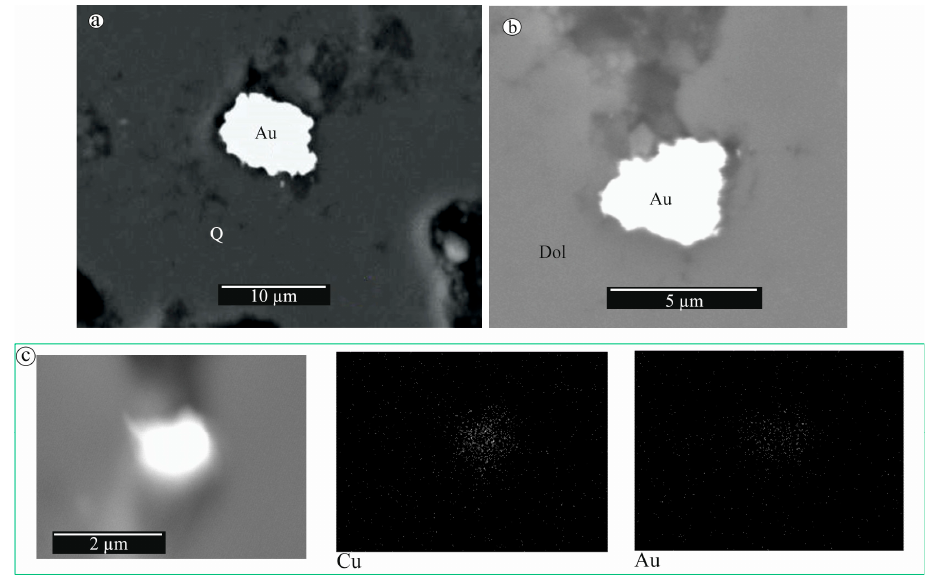
Figure 14. Fine gold (Au) particles in ( a ) jasperoid, ( b ) apocarbonate quartz-potassium feldspar metasomatites ( c ) copper gold (Cu—18%) and impurity elements in gold in the apocarbonate quartz-potassium feldspar hydrothermal-metasomatic formation (shot in X-ray Au and Cu). Q—quartz; Dol—dolomite.